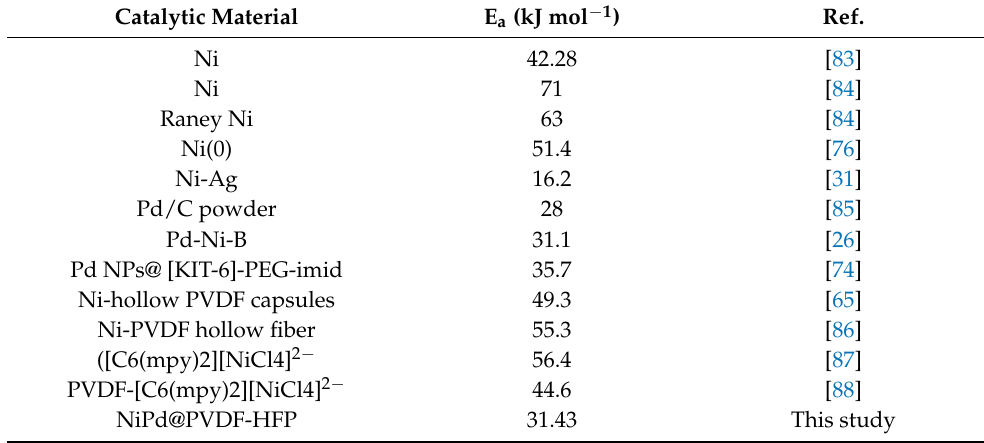
Table 3. E a of prepared NFs, and catalysts based on Pd and Ni used in H 2 generation using NaBH 4 .